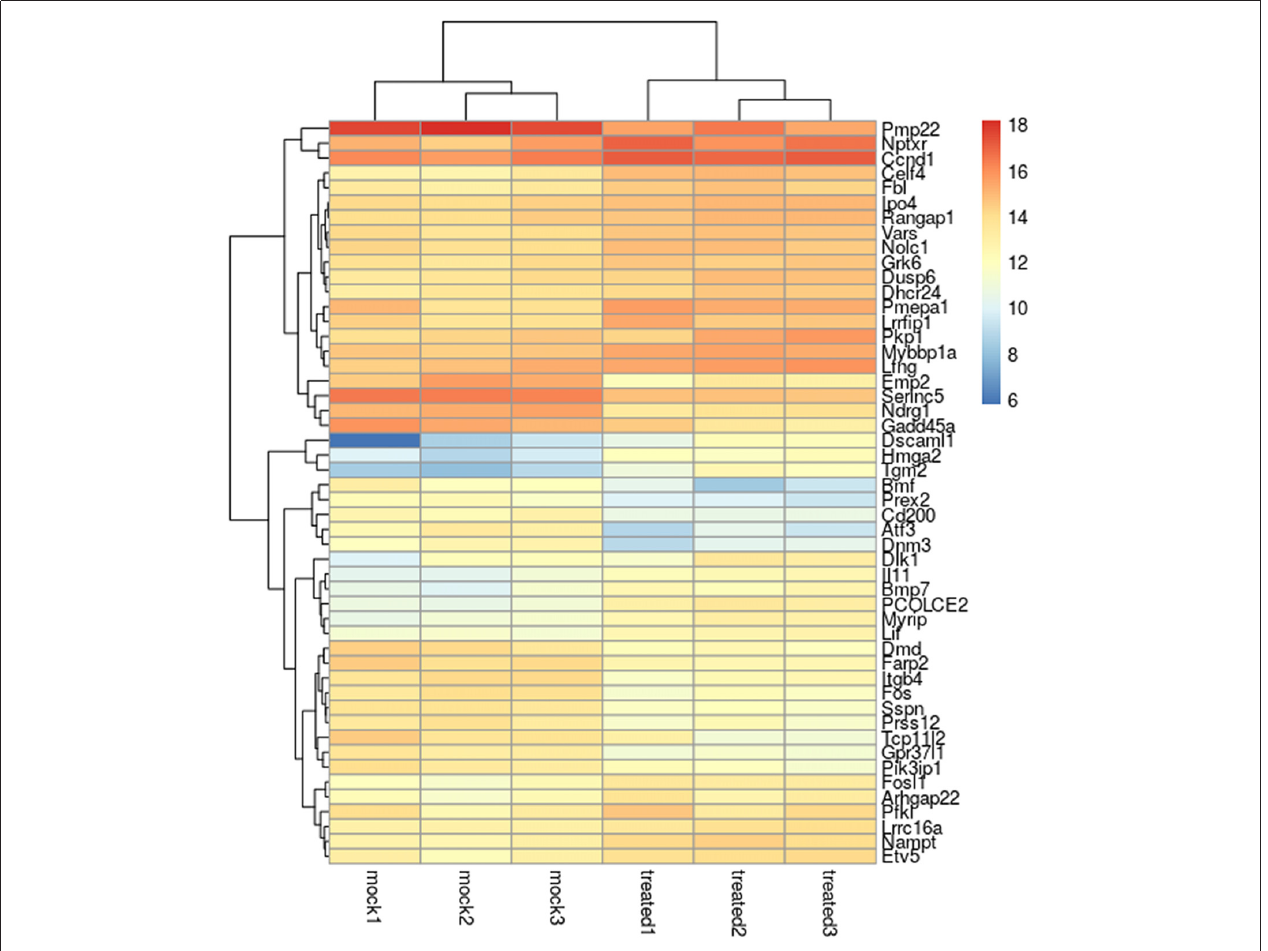
FIGURE 1 | Heatmap of the 50 most differentially regulated genes in Schwann cells. The heatmap shows the biological triplicate expression of the first 50 differentially expressed genes in Schwann cells stimulated with 10 nM NRG1 β 1 based on the obtained P value. “Mock” corresponds to samples treated with the vehicle, “treated” corresponds to samples treated with NRG1 β 1. Colour intensity reflects the expression level and represents the log 2 (RPKM + 1) of the observed gene in each sample (RPKM, Reads Per Kilo base of transcript per Million mapped